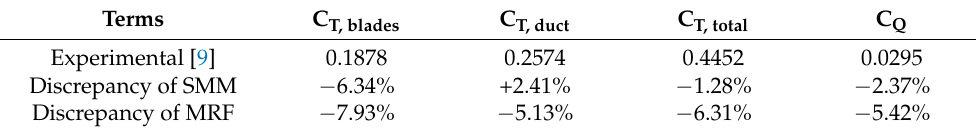
Table 4. Comparison between results obtained via MRF method, sliding mesh method, and